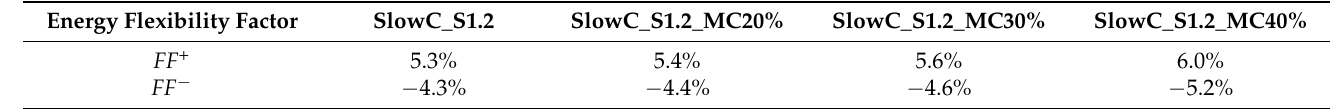
Table 7. Energy flexibility factors FF + and FF − of peak shaving